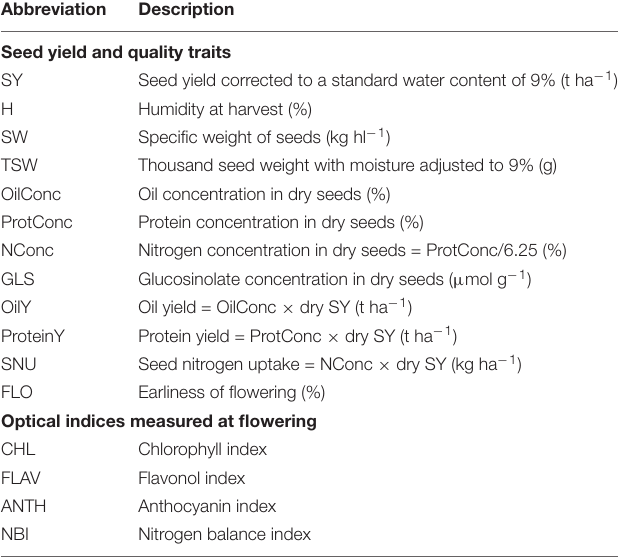
TABLE 1 | Definition of biomass production and root morphological traits measured in hydroponically grown plants.